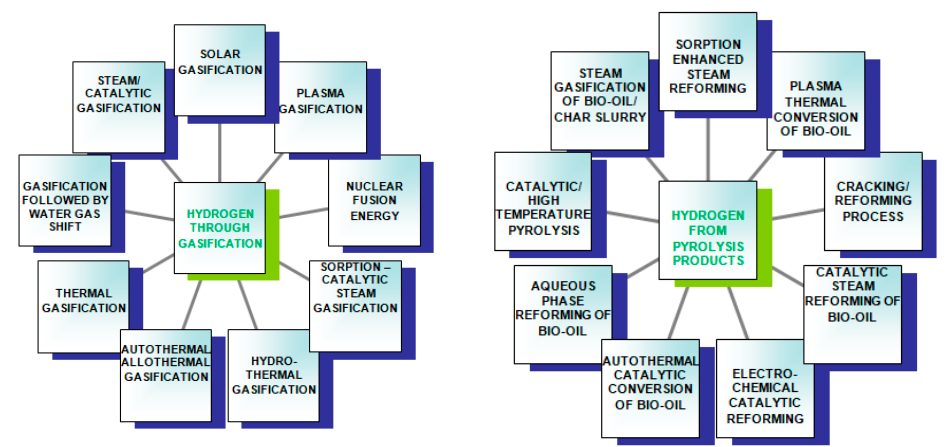
Figure 9. Representative thermochemical methods of biohydrogen production from biomass.